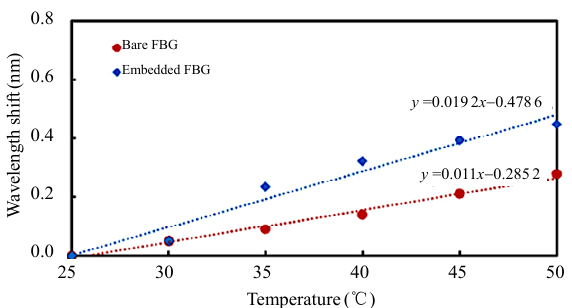
Fig. 8 Temperature sensitivity of bare (red) and embedded (blue)